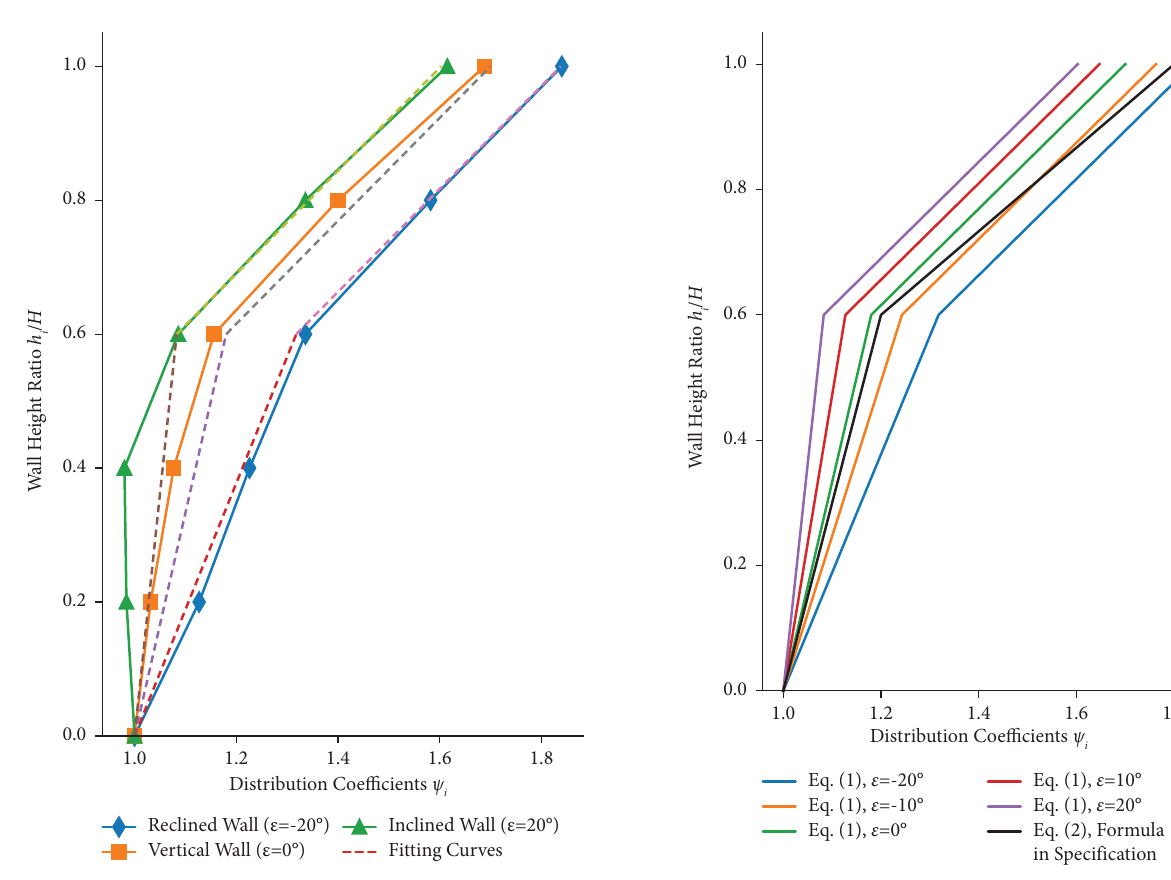
Figure 10: Comparison curve of results of Exp. (2) and Exp. i .